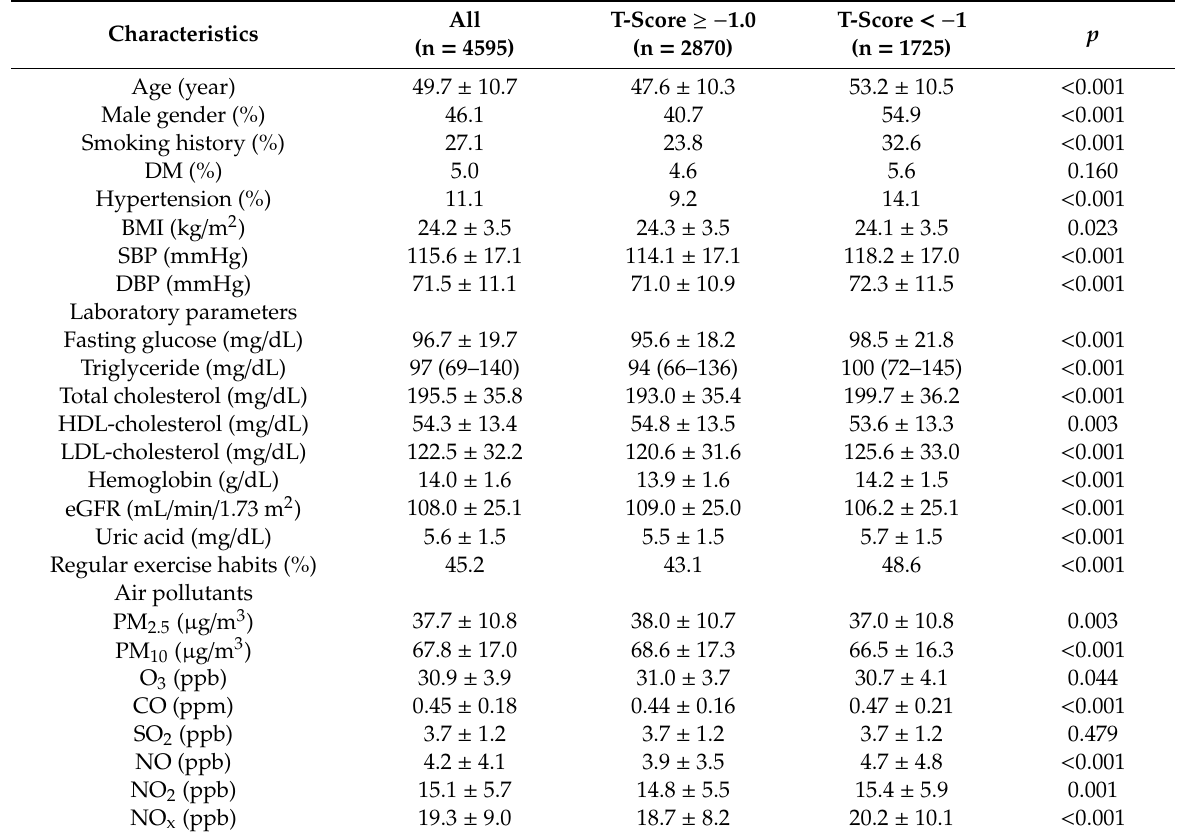
Table 1. Comparison of clinical characteristics among participants according to bone mineral density (BMD) T score ≥ − 1.0 or < −